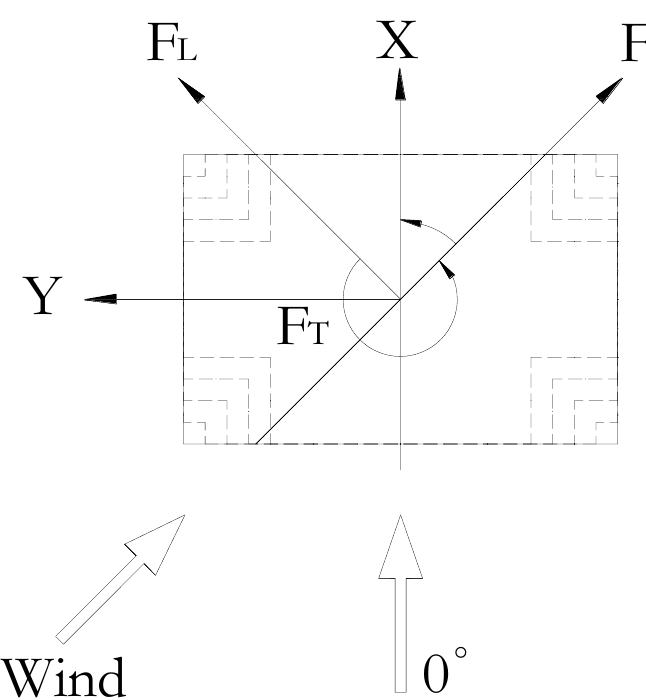
Figure 8. The definition of wind forces and wind attack angle.